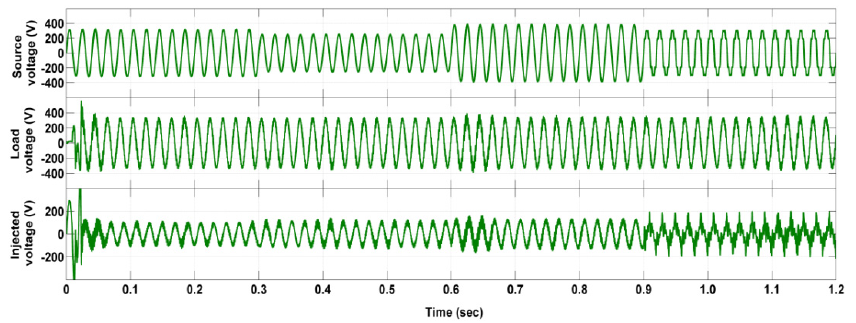
Figure 9. Simulation results with non ‐ linear load only: source voltage, load voltage and series in ‐ jected voltage (top to bottom).